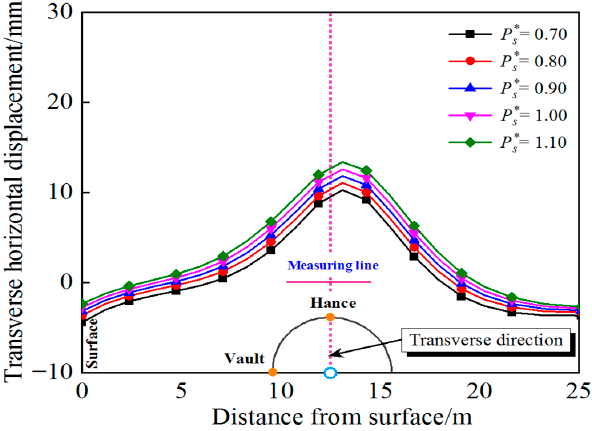
Figure 15. Horizontal deformation of the stratum along the axis direction under different support pressure ratios P ∗ s .